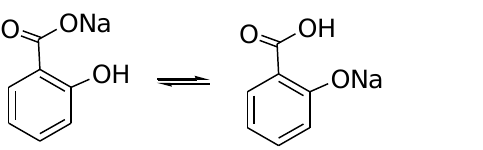
Scheme 4. Equilibrium of the phenolate form and carboxylate form in sodium salicylate.